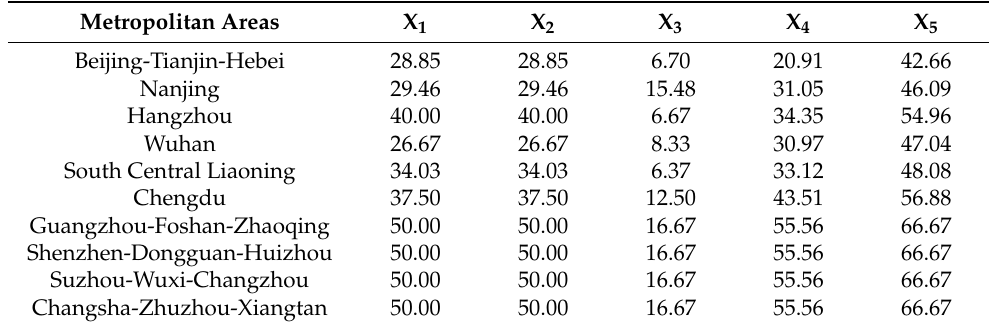
Table 4. The mean values of five centrality indicators in ten metropolitan areas from 2019 to